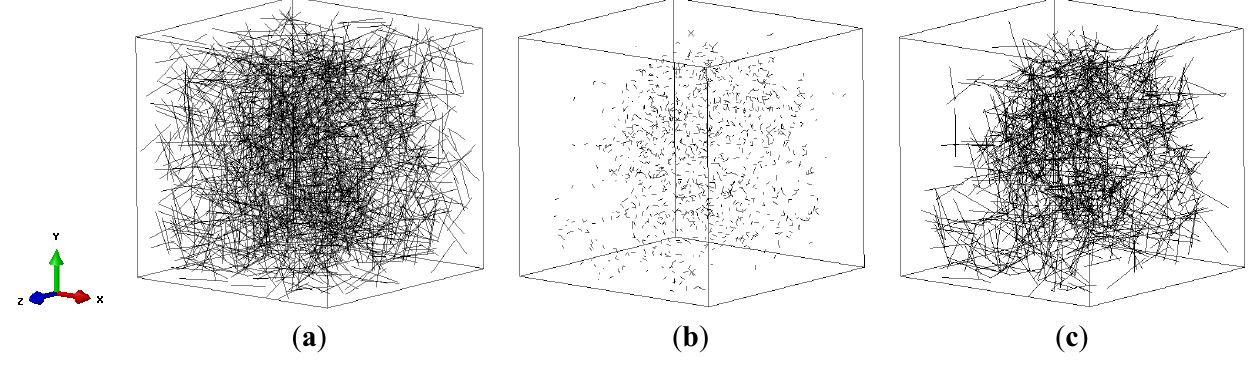
Figure 1. Representative volume element (RVE) with random distributed fibers ( a ) Before cross-linking; ( b ) Crosslinks; ( c ) Cross-linked fiber